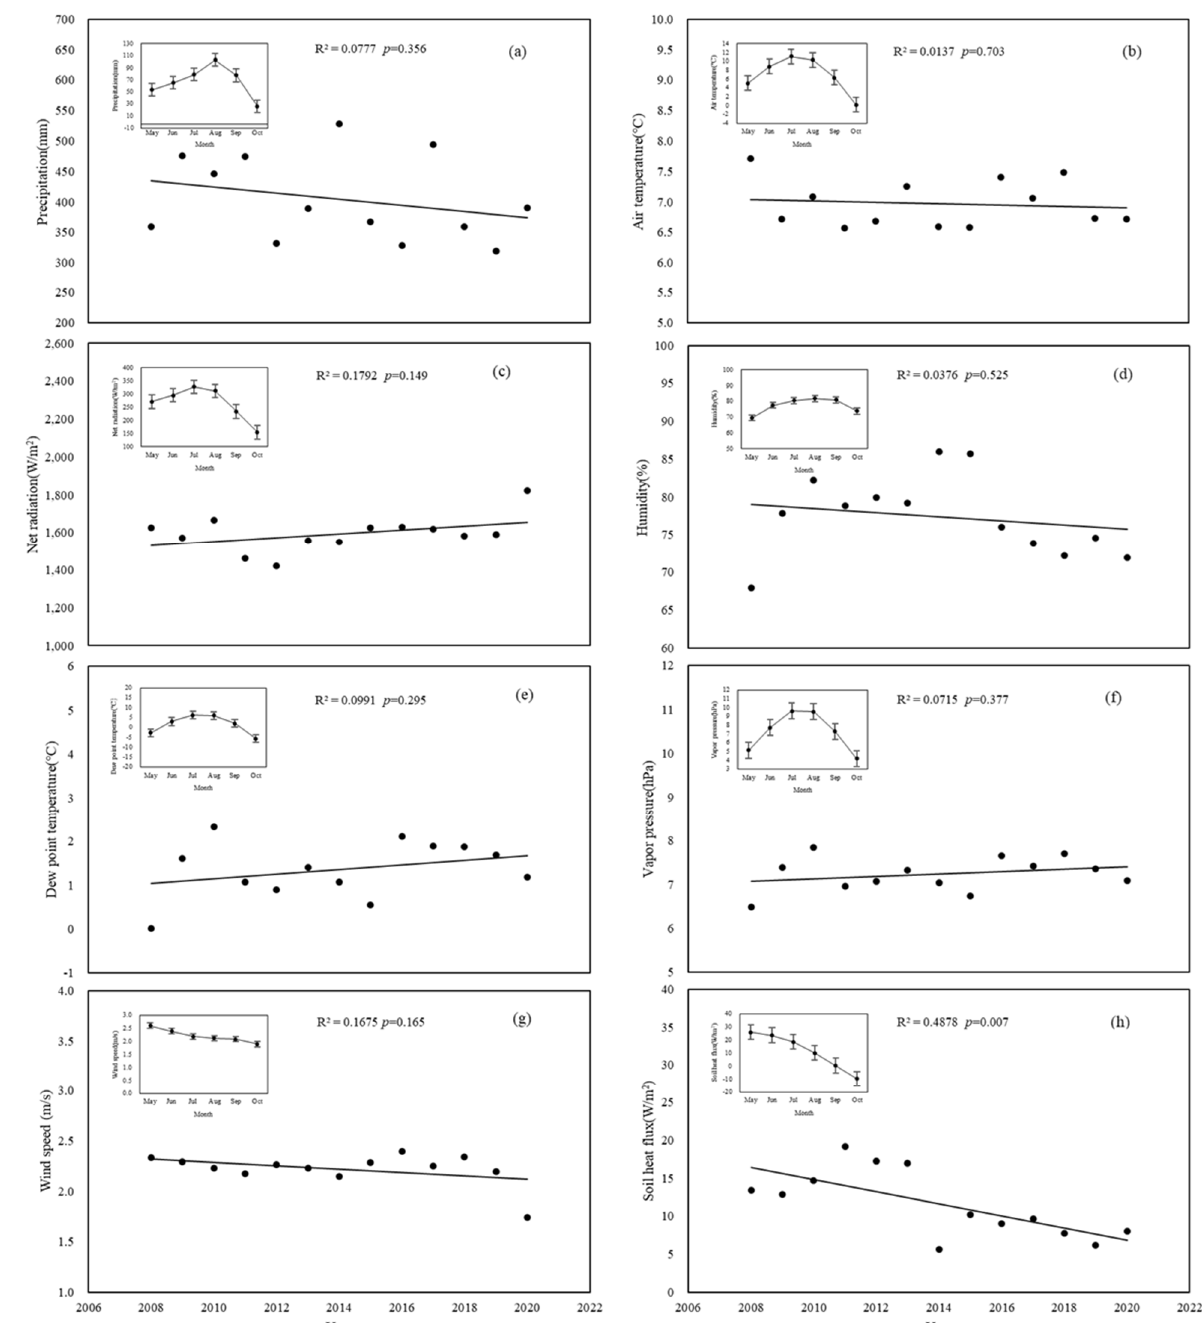
Figure 2. Change trend of meteorological elements from 2008 to 2020. ( a ) Indicates precipitation, ( b ) indicates air temperature, ( c ) indicates net radiation, ( d ) indicates humidity, ( e ) indicates dew point temperature, ( f ) indicates vapor pressure, ( g ) indicates wind speed, and ( h ) indicates soil heat flux.